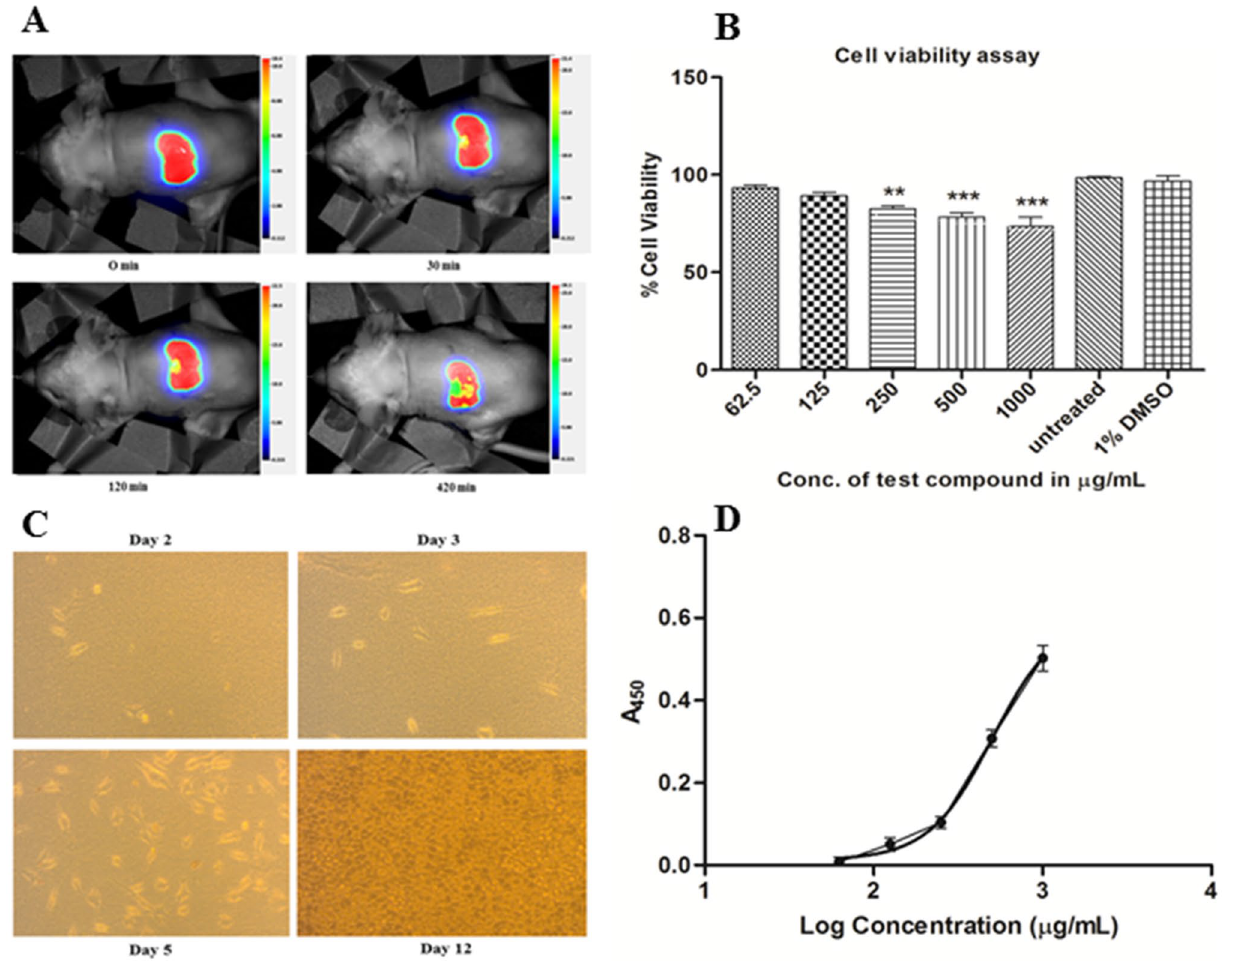
Figure 4. ( A ) Bio-distribution study of AgSD in partial thickness burn wounds of Wistar rats. ( B ) The cytotoxicity effect of hydrogel formulation on L929 cell line. Untreated cells were considered as negative control and 1% DMSO as vehicle control (***p ˂ 0.0001). ( C ) Representative photographs of L929 cells maintained in culture medium. ( D ) Treatment of L929 cells with hydrogel formulation increases cell proliferation as detected by BrdU cell proliferation bFGF-collagen-AgSD hydrogel promotes fibroblast cell proliferation. Figure 4C displayed L929 cells showed active proliferation and fibroblast shaped cells after 2, 3, 5 and 12 days. BrdU cell proliferation assay was performed to investigate the cytotoxicity of AgSD or quantify the cell proliferation induced by bFGF. The